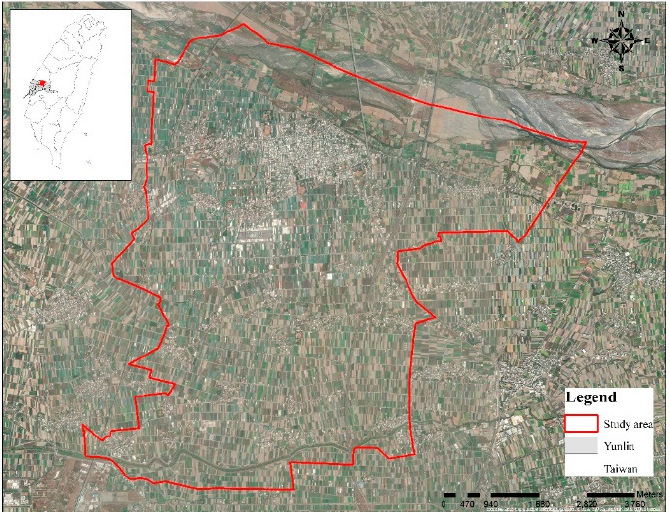
Figure 1. Study area.